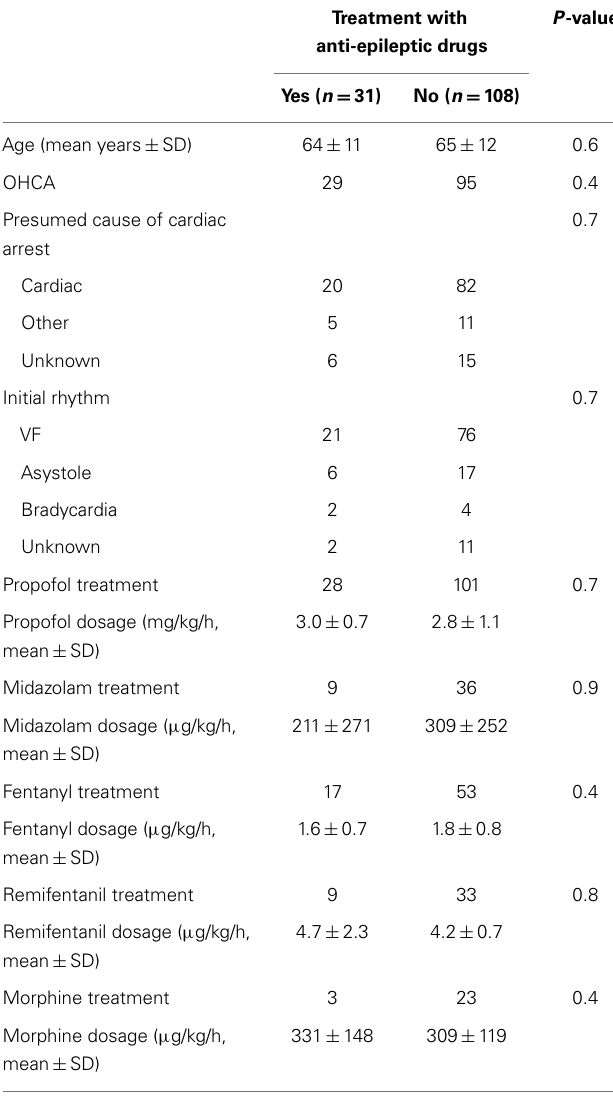
Table 1 | Baseline characteristics of patients treated with and without anti-epileptic